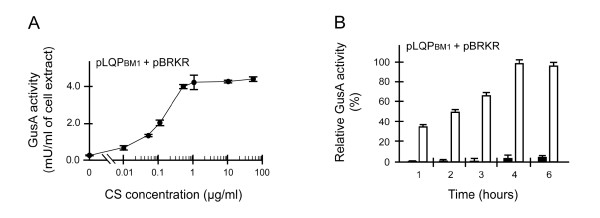
Functional characterization of the CS-CbnK-CbnR system-controlled promoter PBM1 in Lactococcus lactis. Dose-response curve showing GusA activity as a function of CS concentration (A) and time course showing the GusA activity of cultures treated with 20 μg/ml of CS (white columns) or 0.05% trifluoroacetic acid (black columns) (B). In the time course experiment, the cultures were harvested for GusA activity determination at the indicated times. GusA activity was determined as described in Methods. Means ± standard error of triplicate assays are shown.